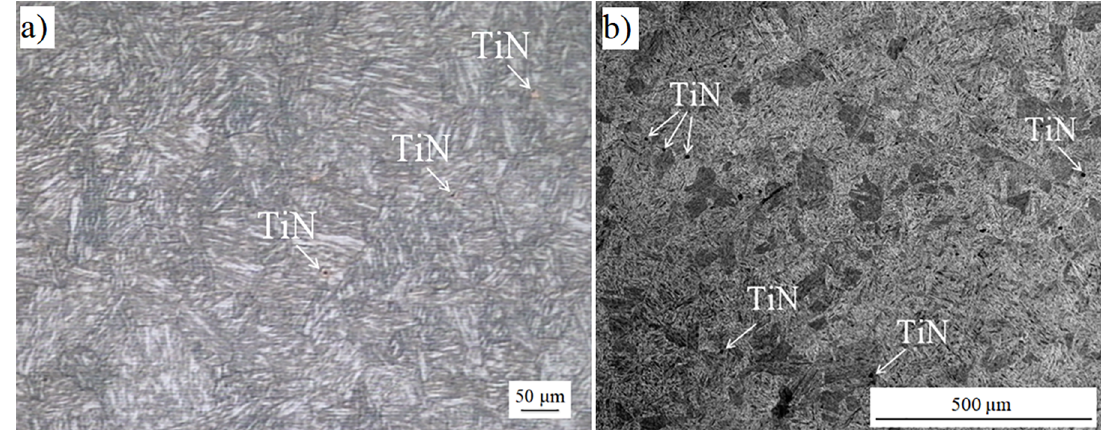
Figure 1. Microstructure of the supermartensitic steel: (a) OM and (b, c, d) SEM. TiN indicated by